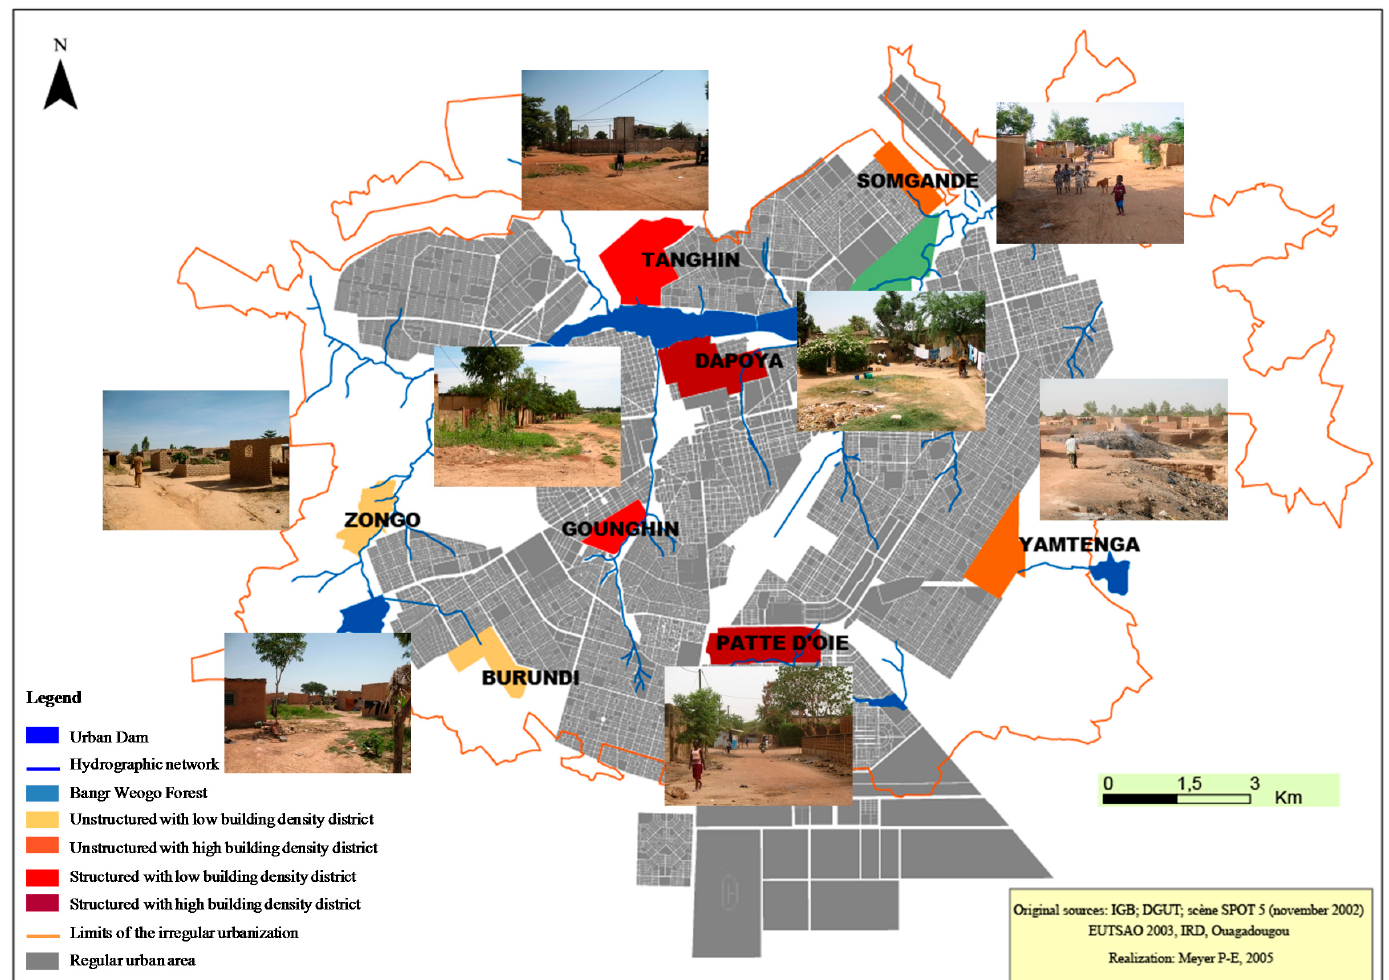
Figure 1. Study area showing the different districts within Ouagadougou city.